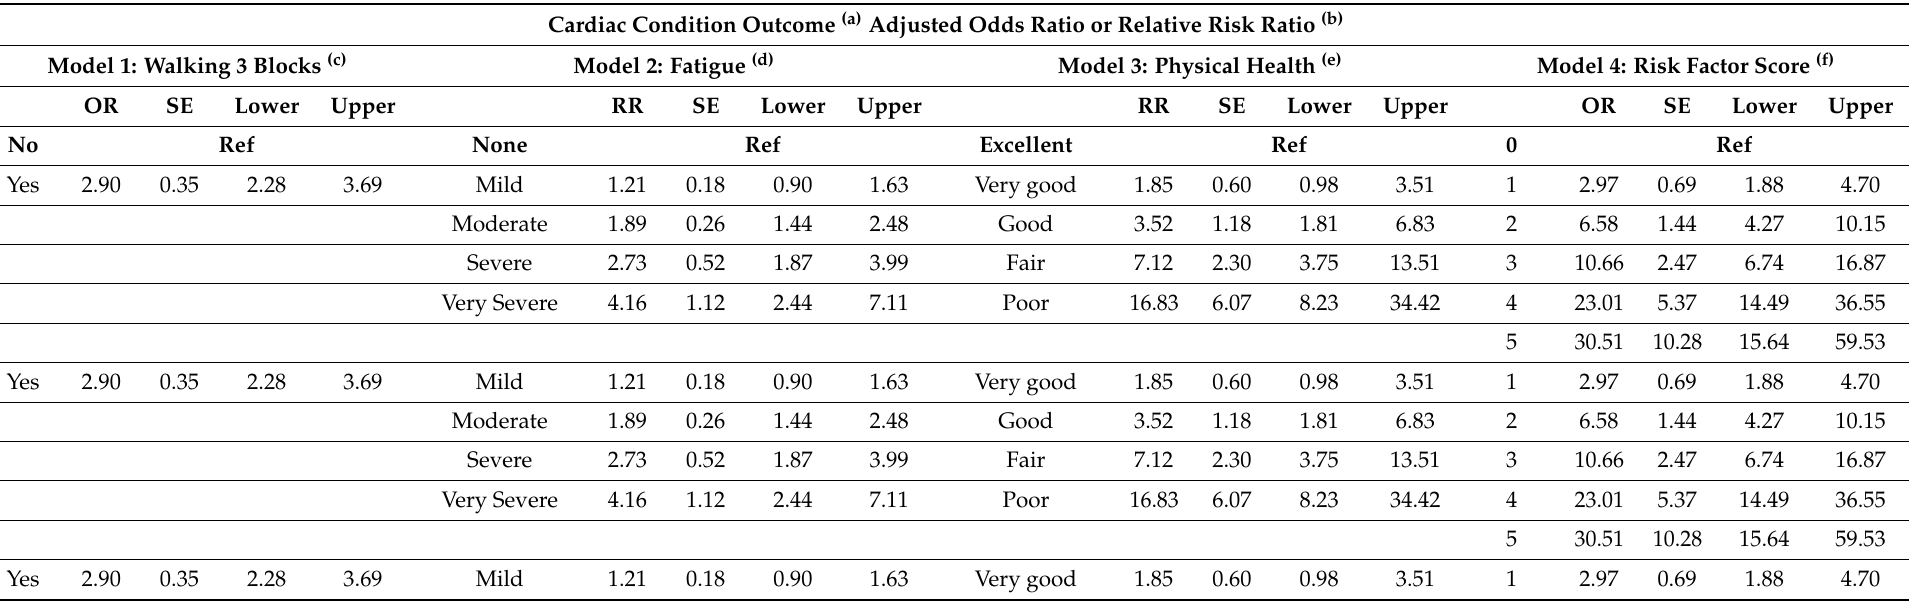
Table 2. Association between Functionally-Important Health Measures and Cardiovascular Disease, Wave 3 ( n =